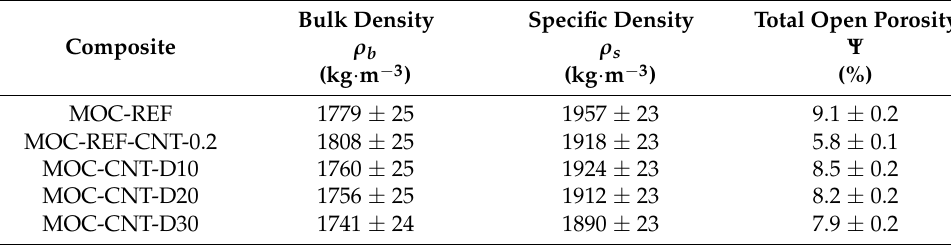
Table 3. Macrostructural parameters of 28 days matured composites.